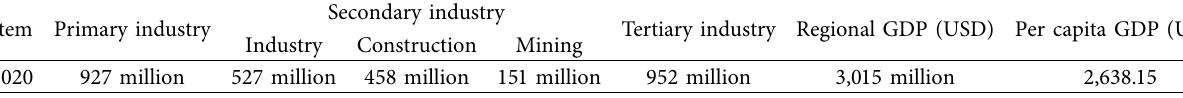
Table 2: GDP structure of the region in 2020.